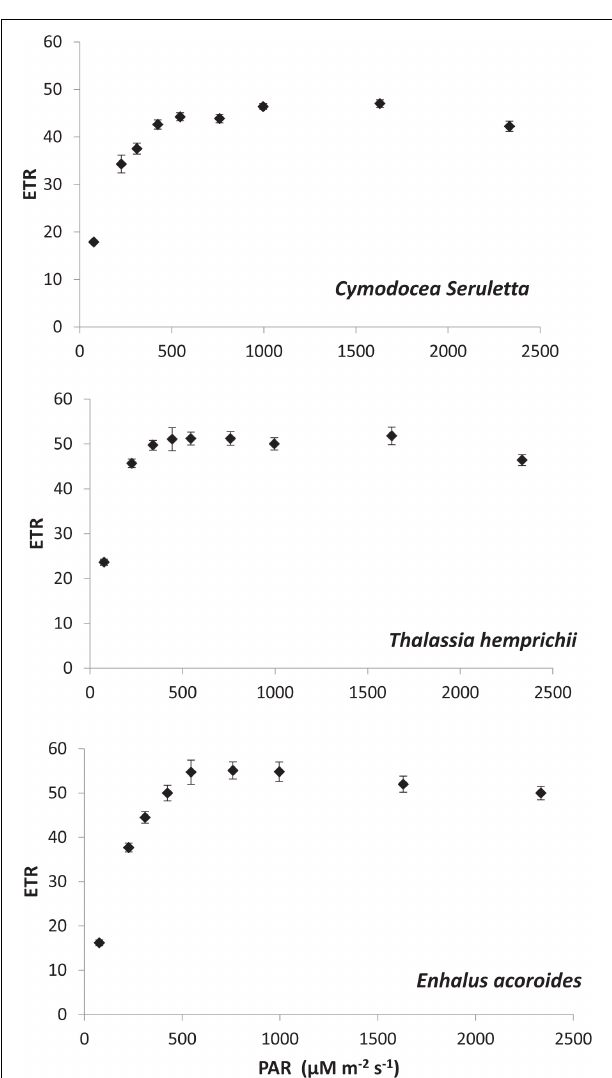
FIGURE 3 | Rapid light curve (RLC) for the three studied species from Palk Bay.